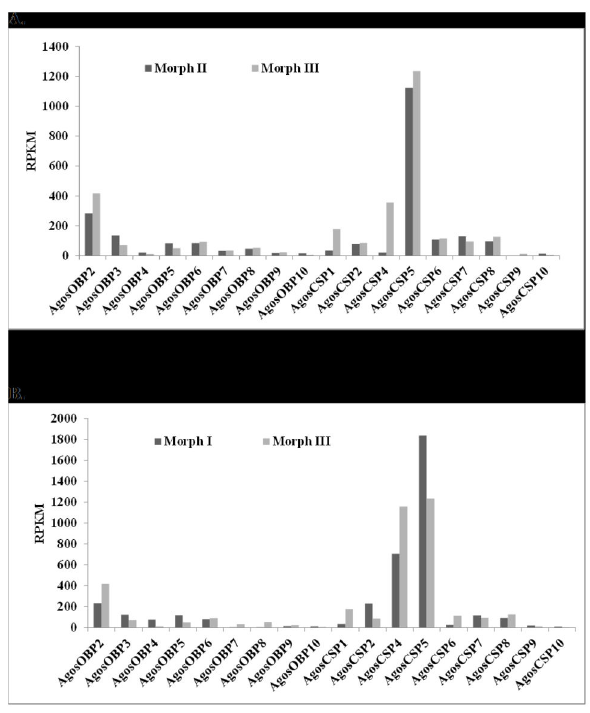
Figure 6. Reads per kilobase pairs per million mapped reads. (RPKM). (A) comparison between Morph I and Morph III A . gossypii (B) comparison between Morph II and Morph III A . gossypii.